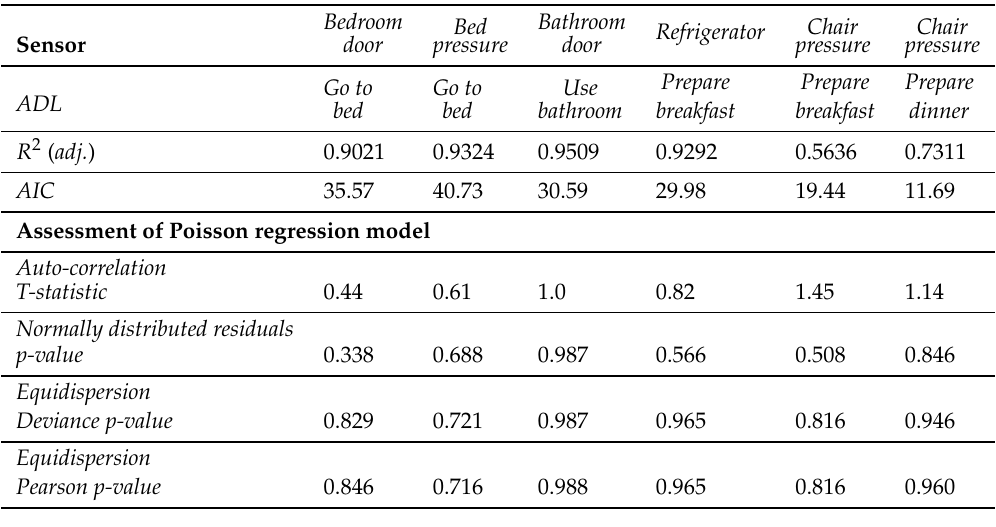
Table 6. Of determination coefficient values and model assessment results for the different